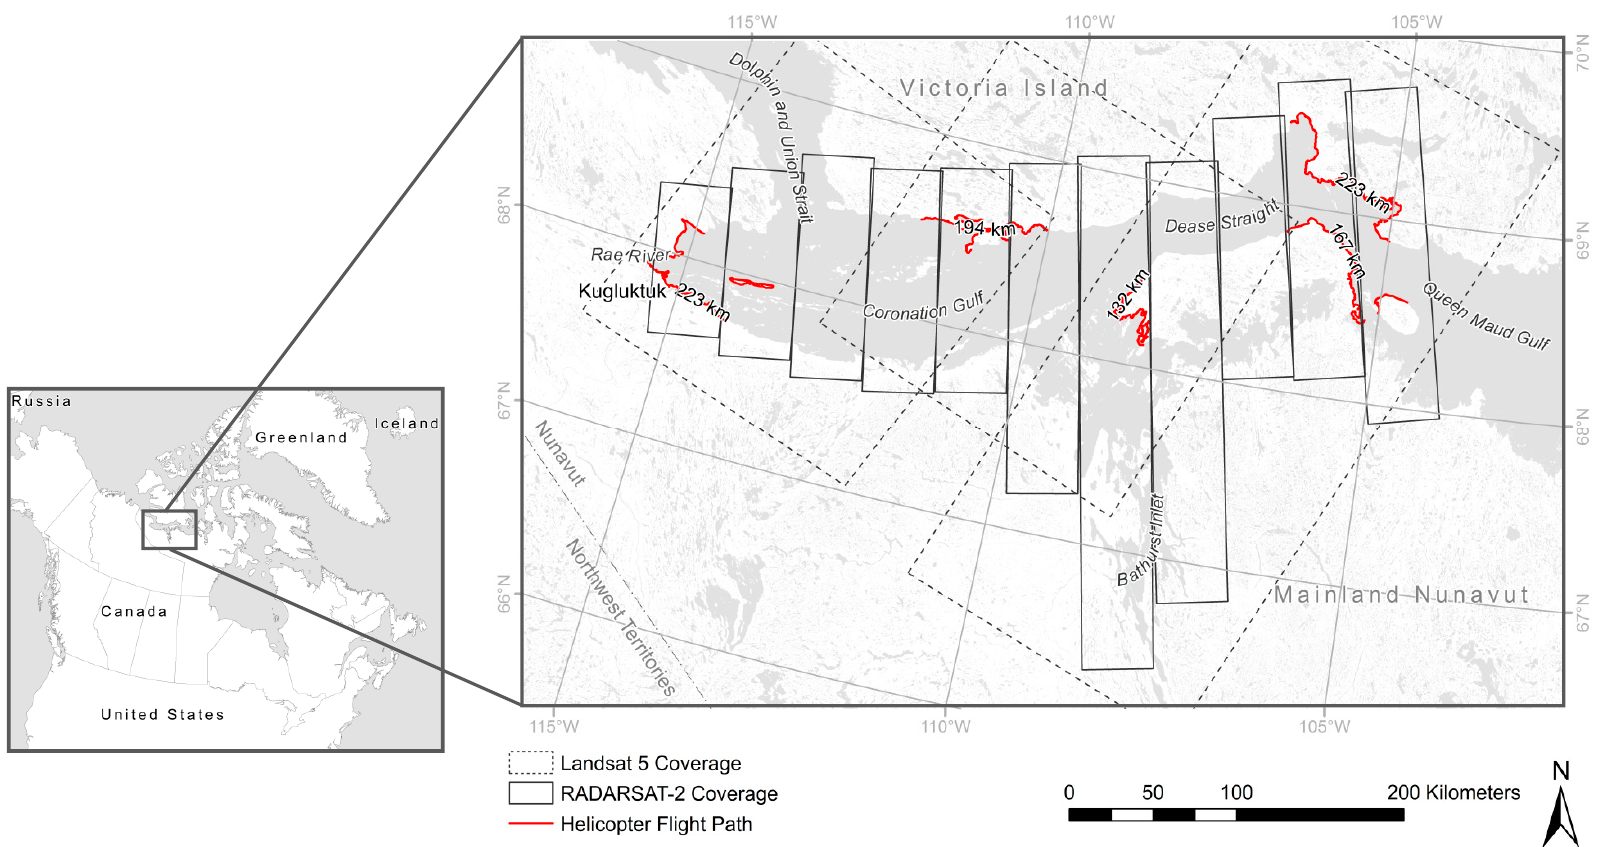
Figure 1. Map showing the footprint of RADARARSAT-2 and Landsat 5 scenes used in this research, and the five sites where helicopter videography data and geotagged photos were collected. Values on each line segment indicate the approximate length of shoreline covered by each videography survey (described subsequently). This figure is adapted from [16].